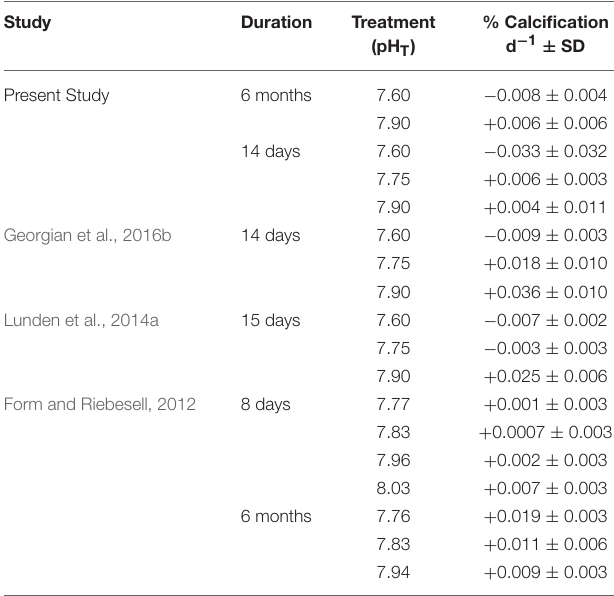
TABLE 3 | Short- and long-term net calcification rates measured with the buoyant weight technique.